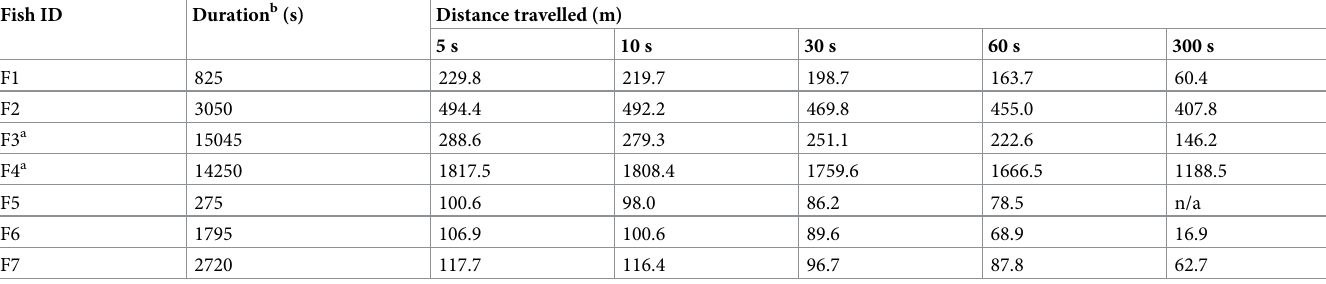
Table 6. Duration and distance travelled in five resampling intervals of movement routes of seven tagged Siebold’s wrasses. Fish